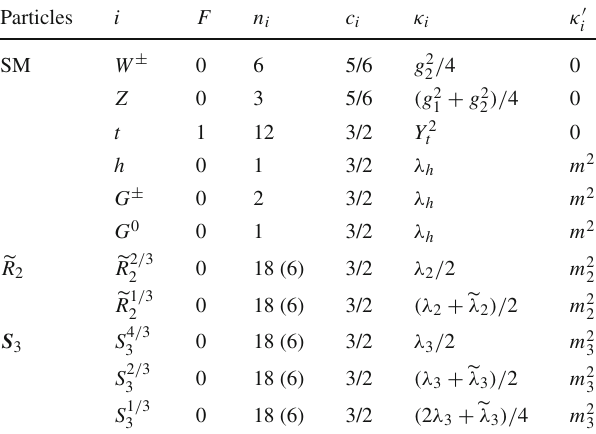
Table 2 Different particles and the corresponding coefficients which contribute to the Coleman–Weinberg effective potential cf. Eq. (76). Here, the number of degrees of freedom for three generations of lepto- quarks, i.e. 18, is shown outside the parentheses, while the same with one generation of leptoquark, i.e. 6, is listed inside the brackets